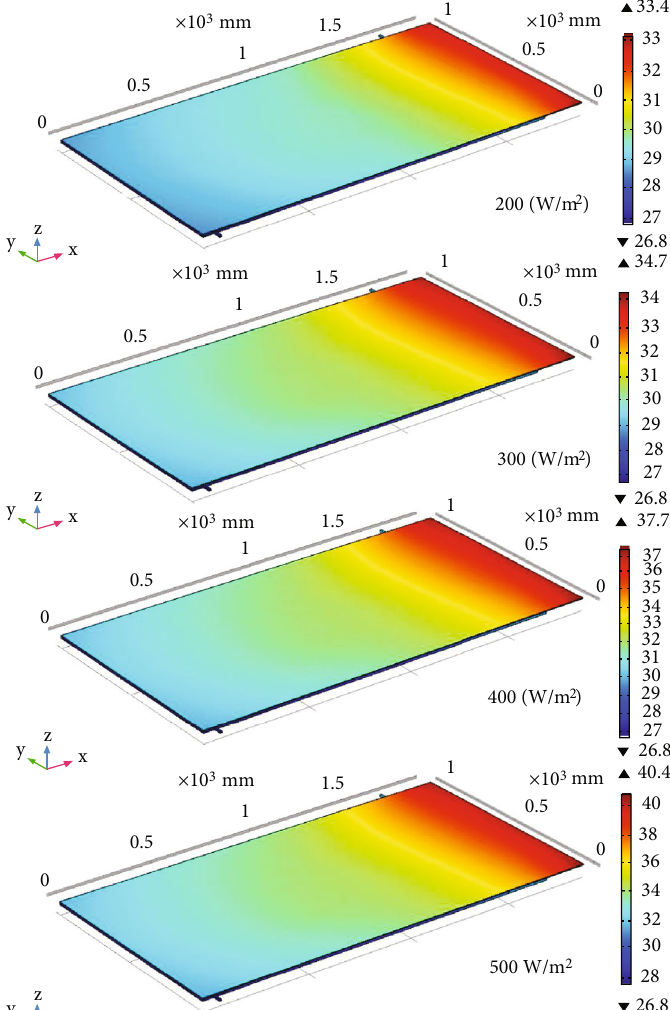
Figure 4: Outcome of irradiance on PVT surface temperature with V